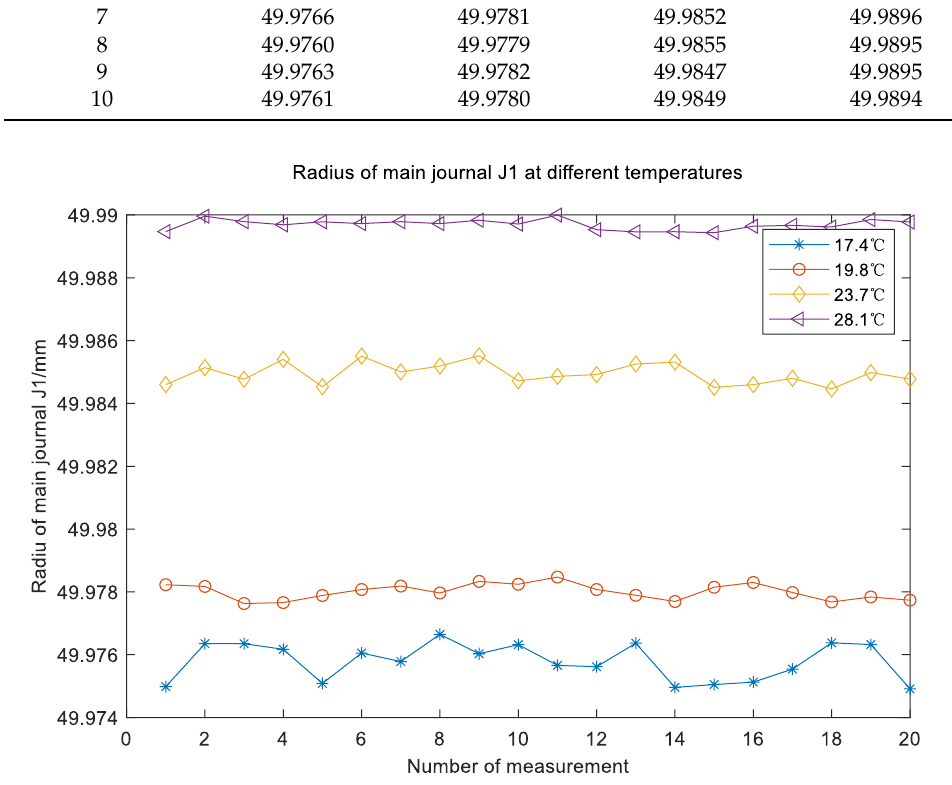
Figure 12. Measured radius before temperature compensation.